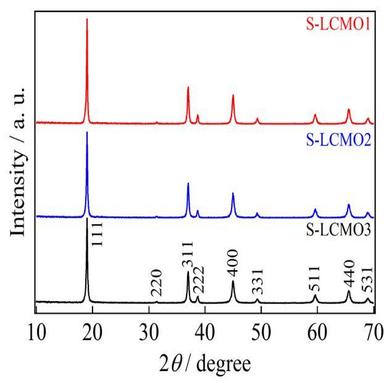
X-ray diffraction patterns of S-LCMO1, S-LCMO2, and S-LCMO3.